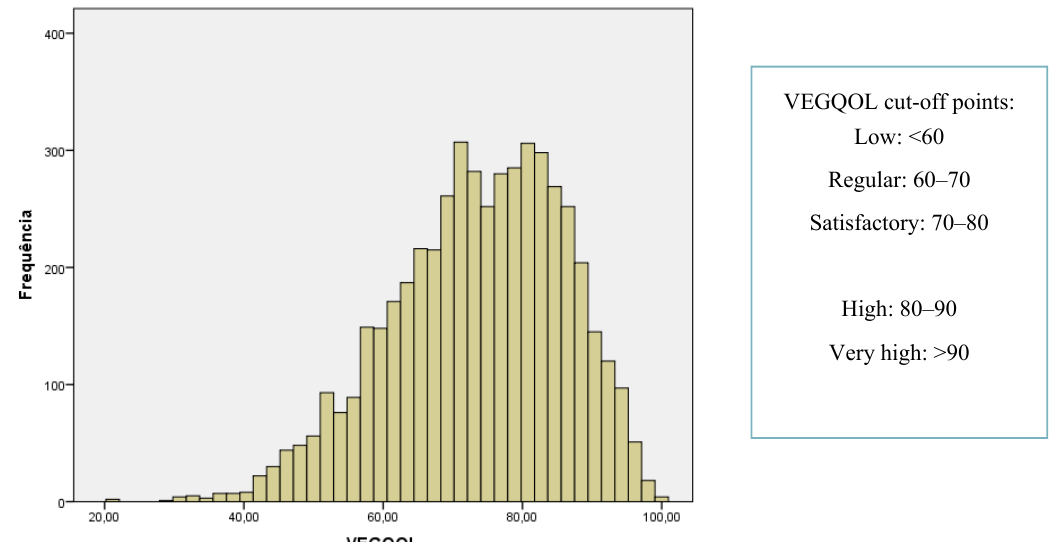
Figure 2. Definition of cut-off points and classification of VEGQOL scores .